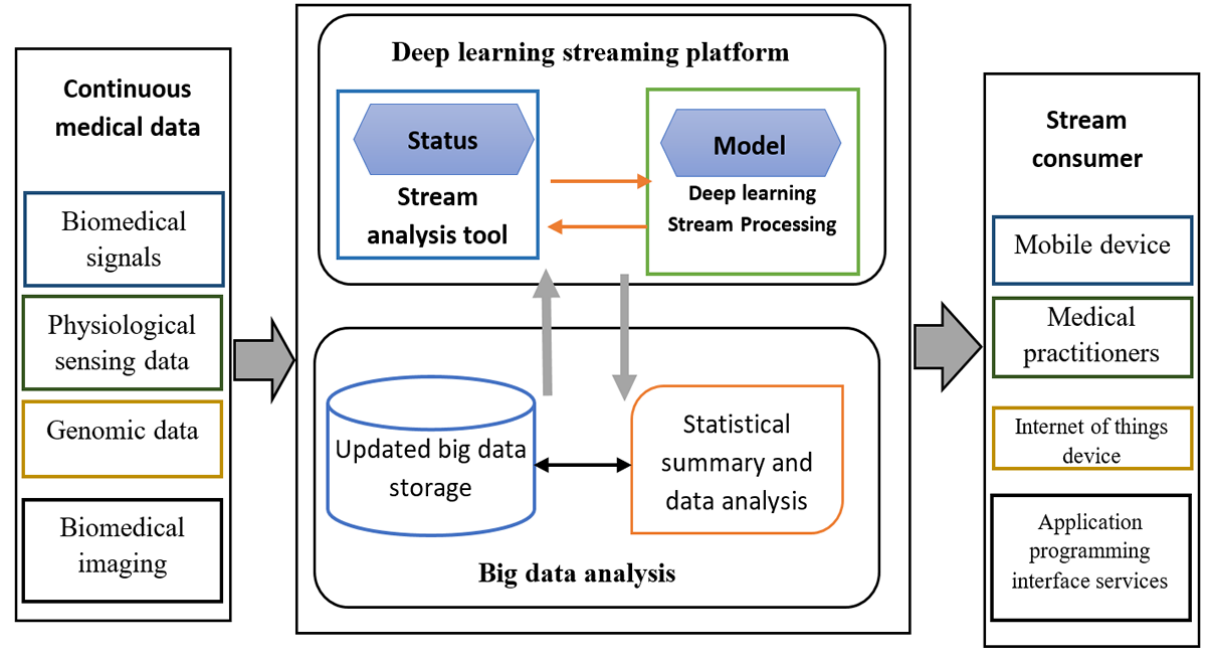
Figure 17. Deep learning biomedical data streaming architecture, challenges, and